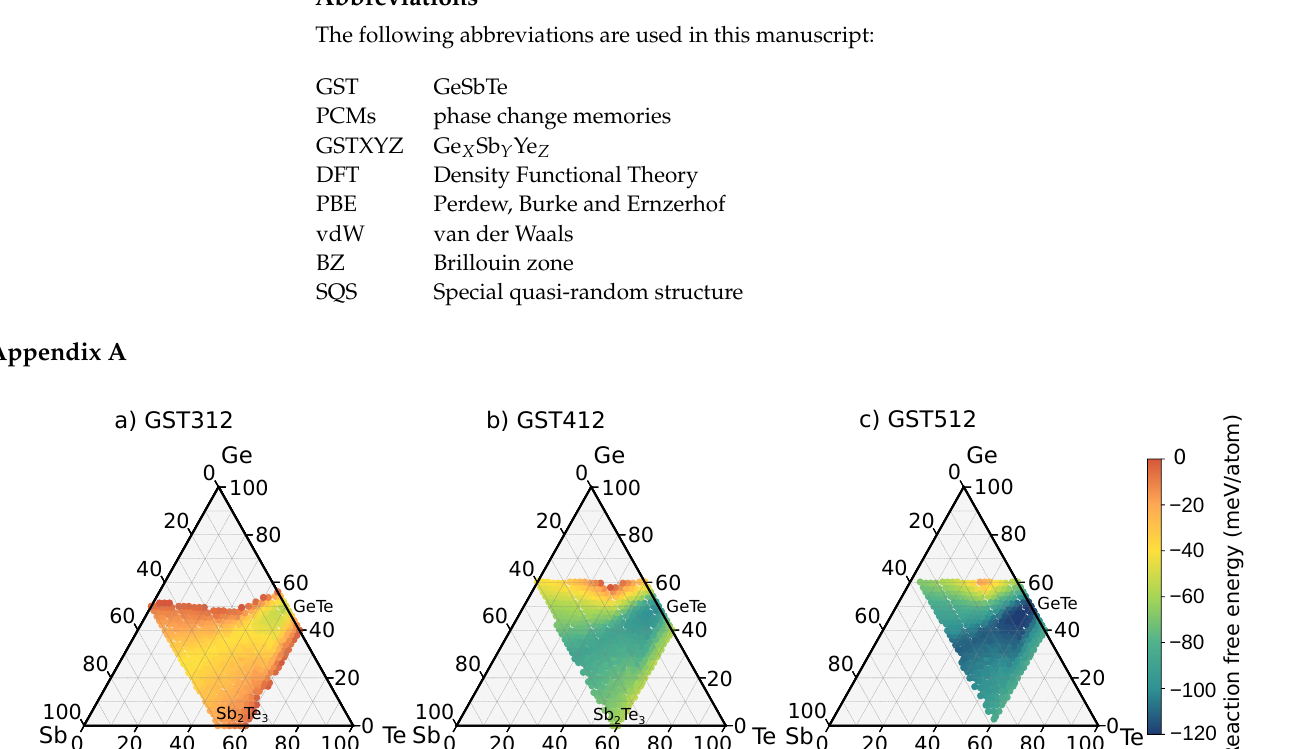
Figure A1. Maps of the decomposition pathways during crystallization of ( a ) GST312, ( b ) GST412, and ( c ) GST512. The color code gives the reaction free energy (meV/atom) to form the cubic alloys on the ternary phase diagram starting from the reactant, i.e., GST312 in panel ( a ) (see text). In these maps the Sb 2 Te 3 product is considered in the trigonal phase as opposed to the maps in Figure 3 where the cubic phase was used for Sb 2 Te 3 as